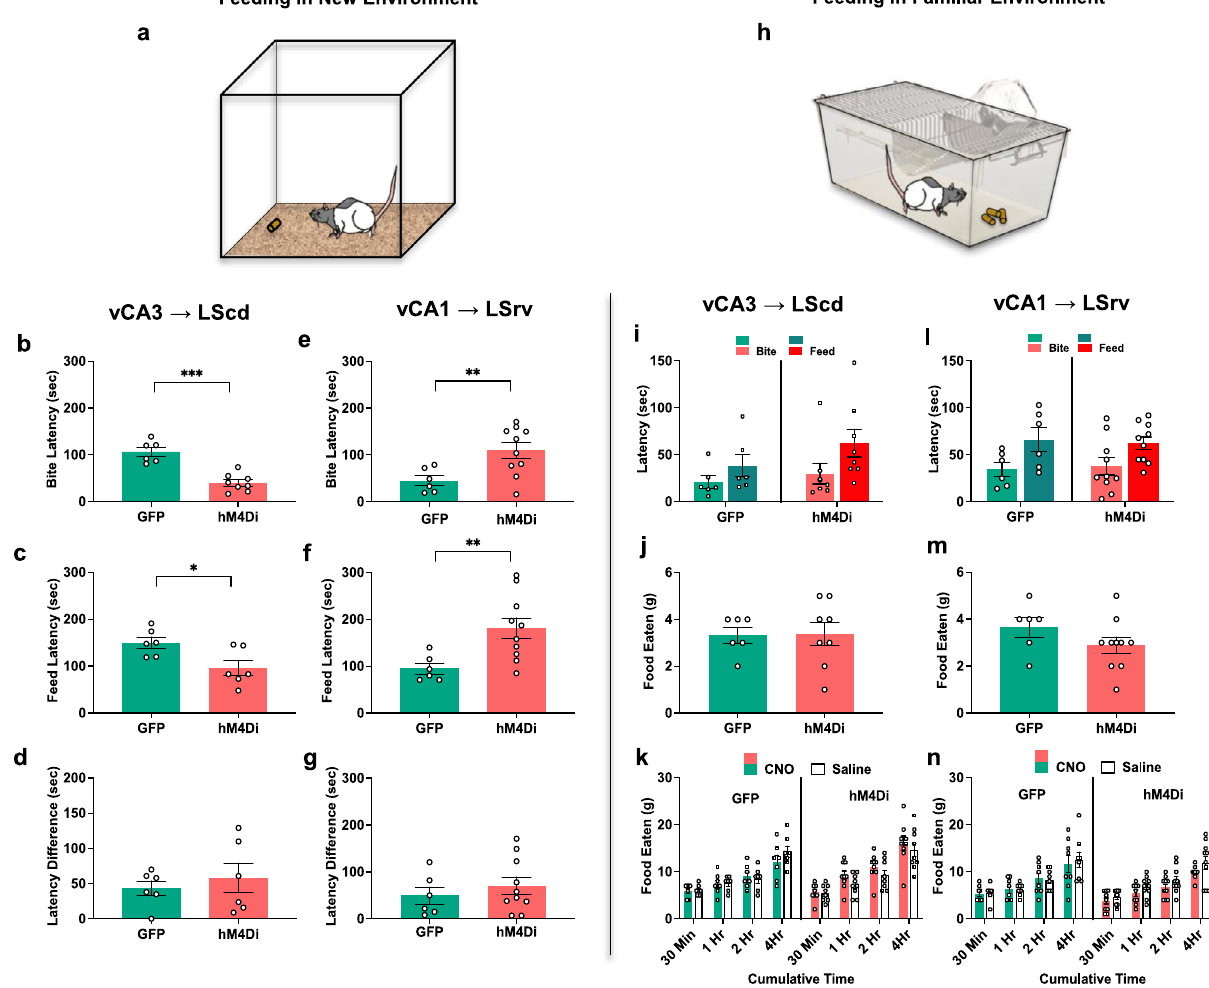
Fig. 5 vHPC → LS circuits exert differential effects on food approach in a novel environment, but not familiar environment. a NESF test schematic. b vCA3 → LScd hM4Di animals were faster to bite the food pellet in the novel environment ( t 12 = 5.94, p = 0.0001) and c faster to start feeding ( t 10 = 2.70, p = 0.0214) compared to GFP controls, d while both groups had similar latencies from bite to feeding ( t 10 = 0.62, p = 0.5349). e vCA1 → LSrv animals were slower to bite the pellet in the novel environment ( t 13.7 = 3.45, p = 0.0097) and f slower to start feeding ( t 12.7 = 3.31, p = 0.0050) compared to GFP controls, while g both groups had similar latencies from bite to feeding ( t 14 = 0.78, p = 0.4379). h Familiar environment feeding schematic. i , l In familiar environments all groups had similar latencies to bite (vCA3 virus: t 12 = 0.62, p = 0.6845; vCA1 virus: t 14 = 0.23, p = 0.8168) and start feeding (vCA3 virus: t 12 = 1.19, p = 0.2622; vCA1 virus: t 14 = 0.31, p = 0.7575), and j , m consumed similar amounts of food in the familiar environment feeding test (vCA3 virus: t 12 = 0.06, p = 0.8233; vCA1 virus: t 14 = 1.38, p = 0.1691). k No difference between vCA3 → LScd groups, with both consuming more food as time progressed in home cage feeding test (Time Bin: F (3,42) = 90.29, p = 0.0001). n Both vCA1 → LSrv groups consumed more food over time in the home cage feeding test (Time Bin: F (3,48) = 72.05, p = 0.0001) and consumed more food overall after CNO, as compared to saline (Drug: F (1,16) = 5.11, p = 0.0427; Drug x Bin: F ( = 0.6579, p = 0.6494). NESF and FESF: vCA3-hM4Di n = 8, vCA3-GFP n = 6, vCA1-hM4Di n = 10, vCA1-GFP n = 6, 3,48 ) unpaired two-sided t- tests with Bonferroni-Holm correction for multiple comparisons. Home cage feeding: vCA3-hM4Di n = 9, vCA3-GFP n = 7, vCA1- hM4Di n = 10, vCA1-GFP n = 8, three-way ANOVAs with Bonferroni-Holm correction for multiple comparisons. Data represent mean ± SEM. * p < 0.05, ** p < 0.01. * denotes between-subject comparisons. Source data are provided as a Source Data fi